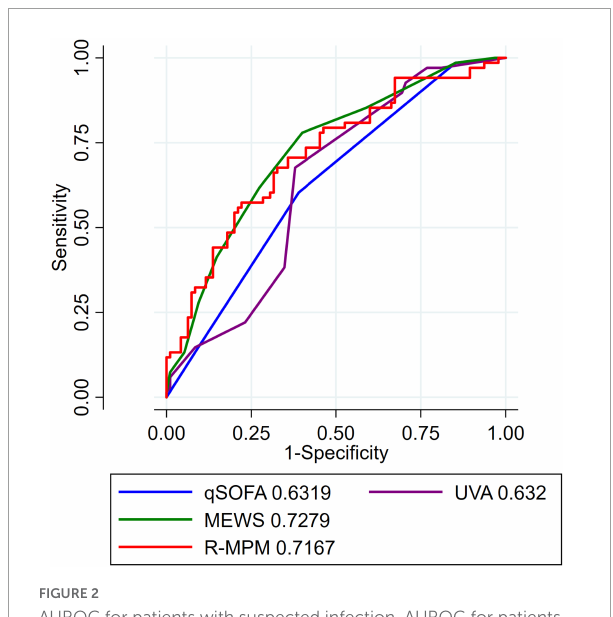
FIGURE2 AUROC for patients with suspected infection. AUROC for patients with suspected infection, defined as receipt of IV antibiotics within 24 h of ICU admission. AUROC, area under the receiver operating characteristic curve; MEWS, Modified Early Warning Score; UVA, Universal Vitals Assessment; qSOFA, quick Sequential Organ Failure Assessment; R-MPM, Rwanda Mortality Prediction